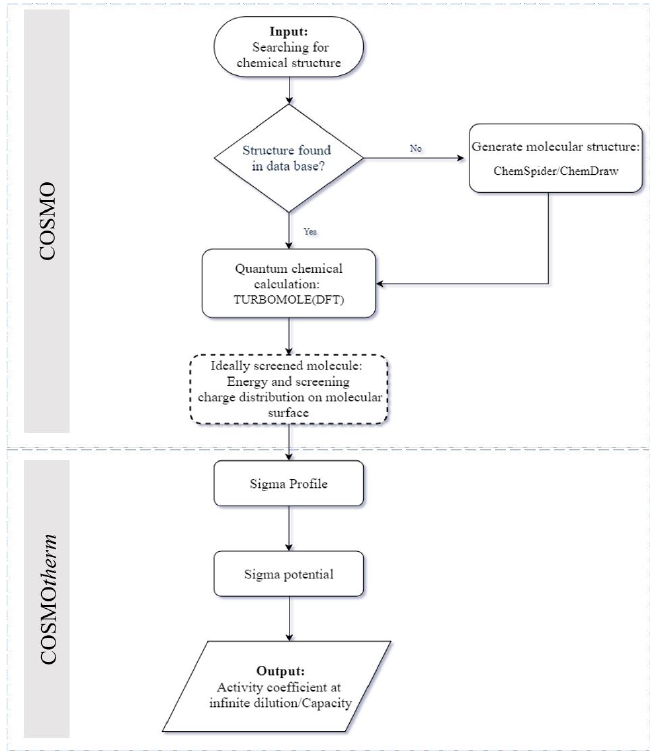
Figure 1. COSMO-RS calculation steps for solid – liquid extraction.